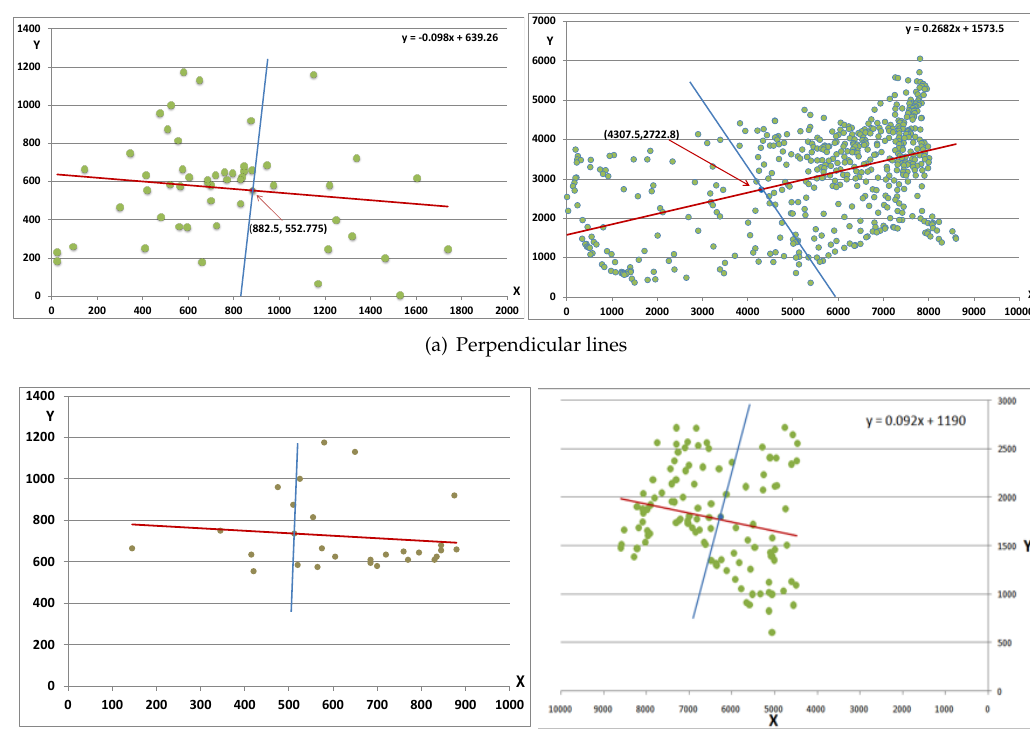
Figure 10. Dividing the domain into four sub-domains based on the computed regression and perpendicular lines for (Left) berlin52, and (Right) att532 and applying again. ( a ) The A, B, C, and D categories are generated from the intersection between regression lines and the perpendicular lines shown in Figure 9c. We then continue the regression and perpendicular lines on these